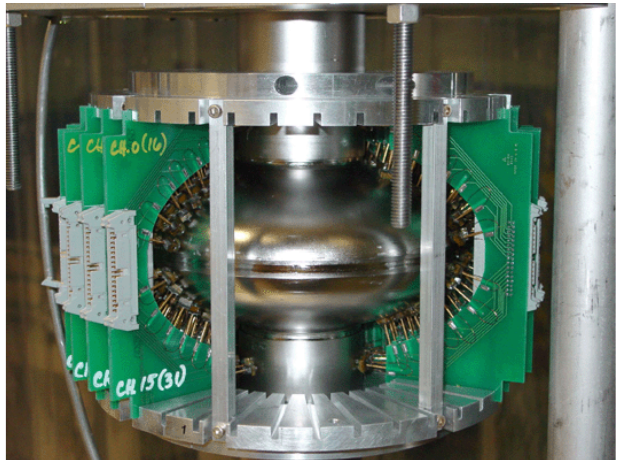
FIG. 1. (Color) Temperature mapping system, assembled on a single-cell cavity.